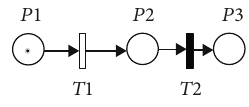
Figure 3: A simple